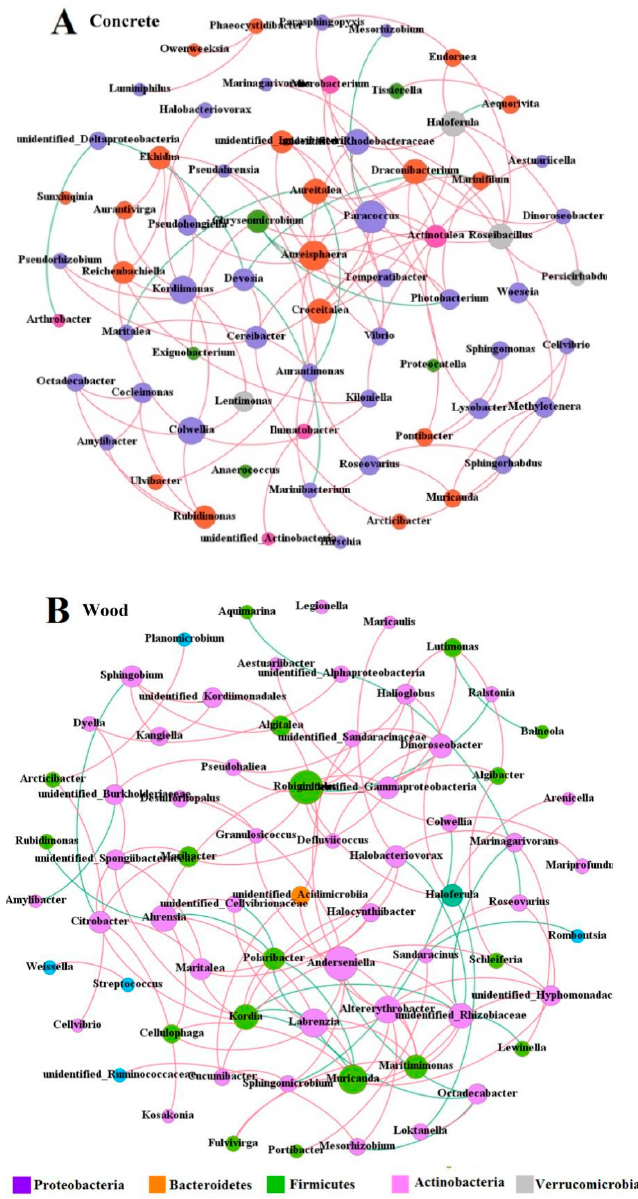
Figure 5. Co-occurrence network analysis at genus level on concrete ( A ) and wooden ( B ) blocks. The node colors represent different phyla. The sizes of genus nodes are proportional to their average relative abundance. The red and green edges represent positive and negative correlations, respectively.